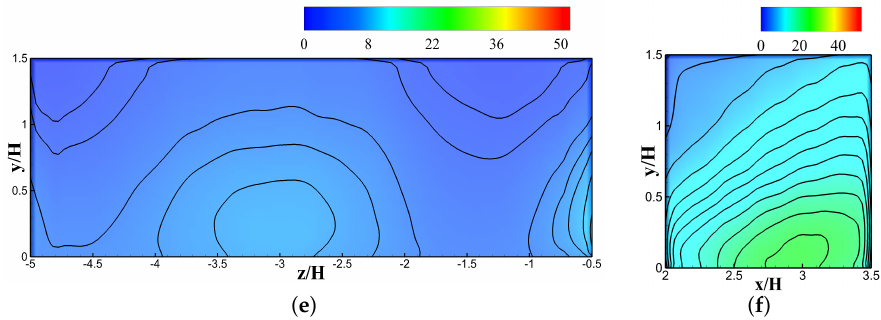
+ (cid:105) data on Building D (downwind